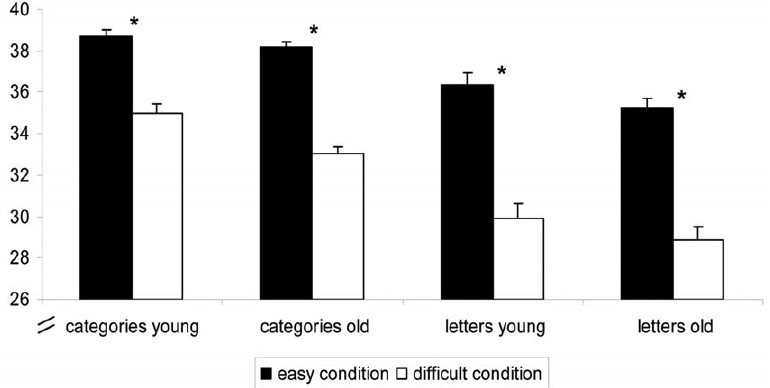
Figure 1. Behavioral performance. Shows absolute performance and the impact of task difficulty in the two age-groups during the semantic and phonemic task. Asterisks indicate significant differences between conditions.